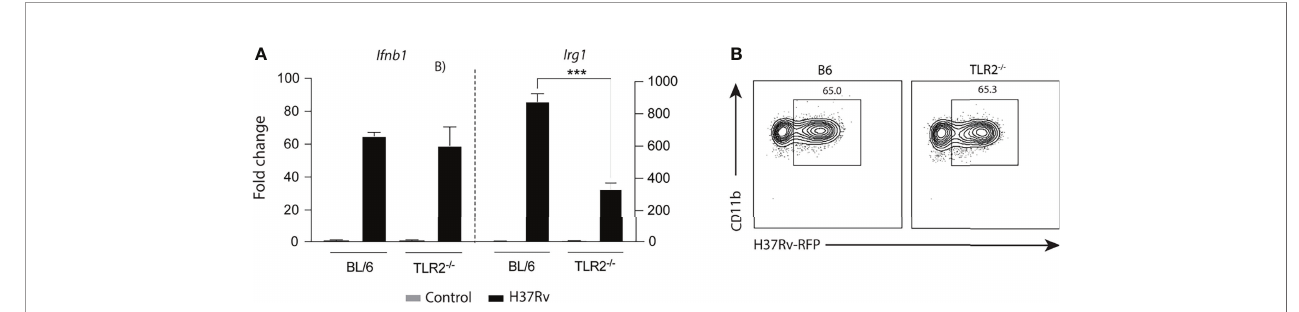
FIGURE 6 | Mtb induced expression of Ifnb1 as well as macrophage bacterial uptake are TLR-2 independent processes. (A) Ifnb1 and Irg1 mRNA levels were assessed in TLR-2 -/- and C57BL/6 BMDM cultures infected with H37Rv (MOI of 1) at 6 h p.i. (B) Internalization of H37Rv-RFP in TLR-2 -/- and C57BL/6 macrophages was measured by fl ow cytometry at 6 h p.i. Signi fi cant differences are indicated with asterisks (***p < 0.001). Results shown are representative of two independent experiments